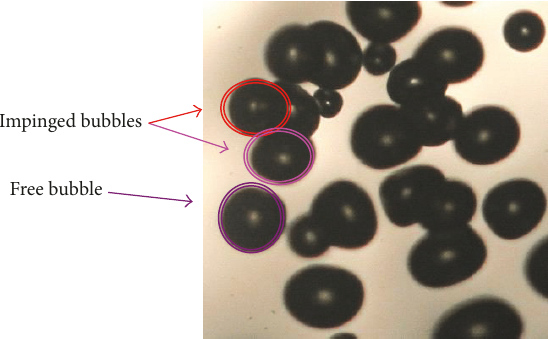
Figure 3: Photograph of a PS (1mm thick × 20 mm diameter) sample 600 sec after the onset of depressurization after holding at 24 bar (CO 2 pressure) and 100 ∘ C for 2 hours, the photograph shows the location of three impinged bubbles and one free bubble that are considered here (scale of images is 6 × 6